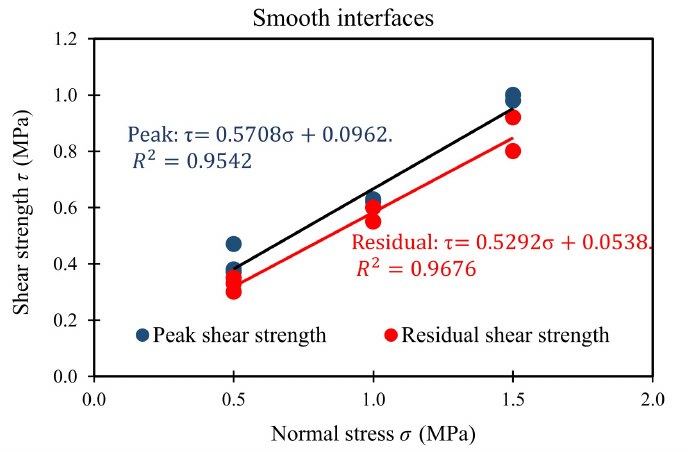
Figure 6. Peak and residual shear strengths in terms of normal stress (smooth